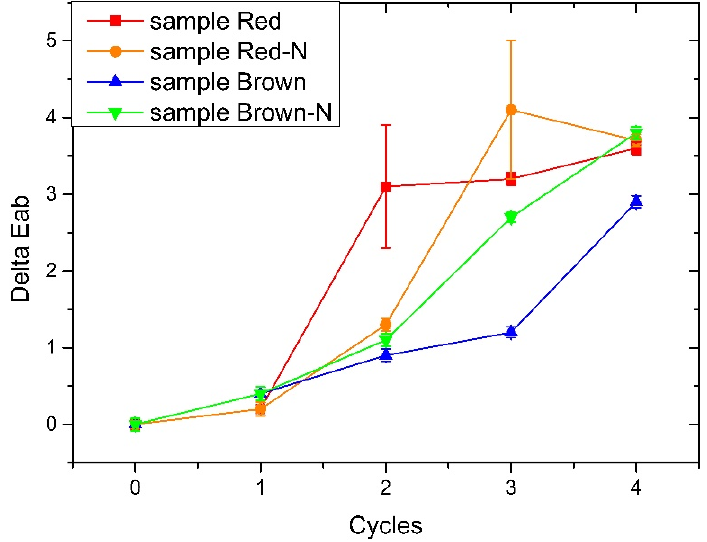
Figure 7. Color difference evolution Δ E ab considering CIELab system as a function of the degradation cycles.